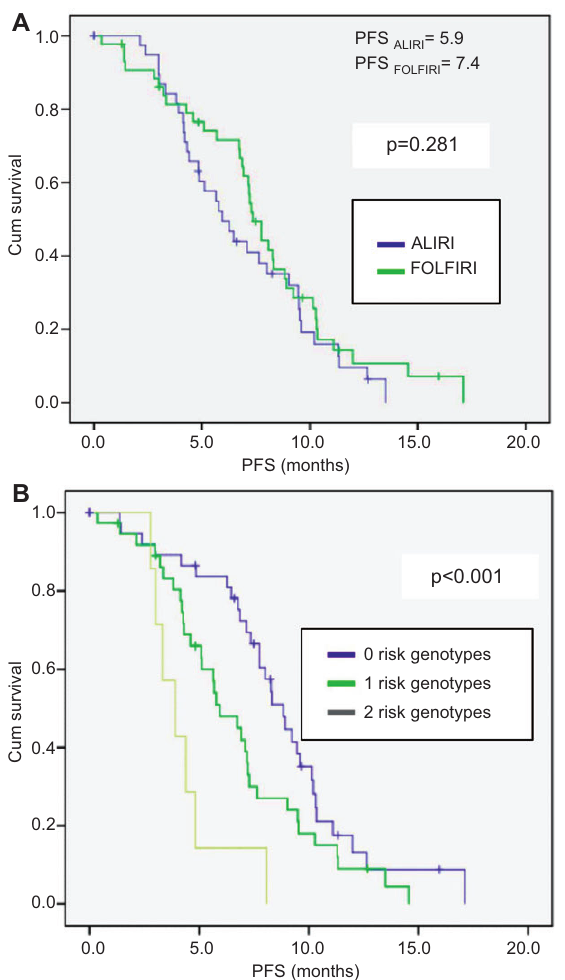
Figure 2 Kaplan-Meier curves showing progression free survival according to treatment group (A) ALIRI or FOLFIRI (A); or according to (B) number of risk genotypes